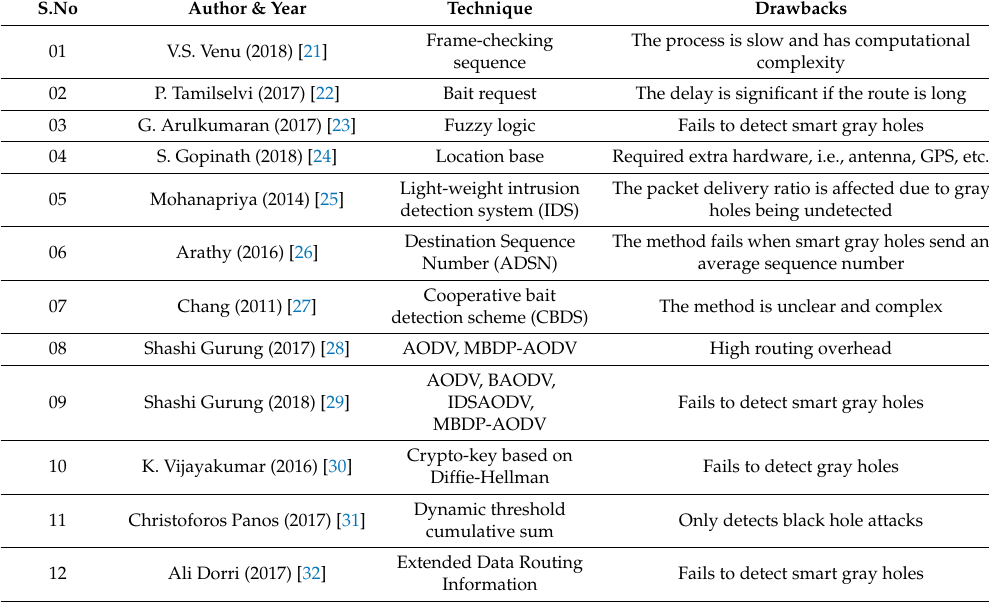
Table 1. Existing techniques along with their